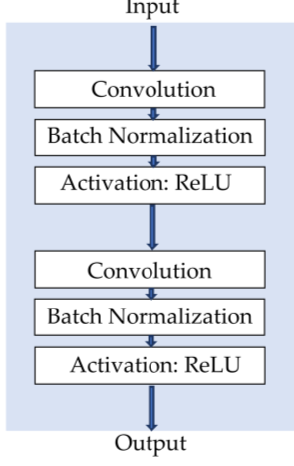
Figure 3. Convolution block.